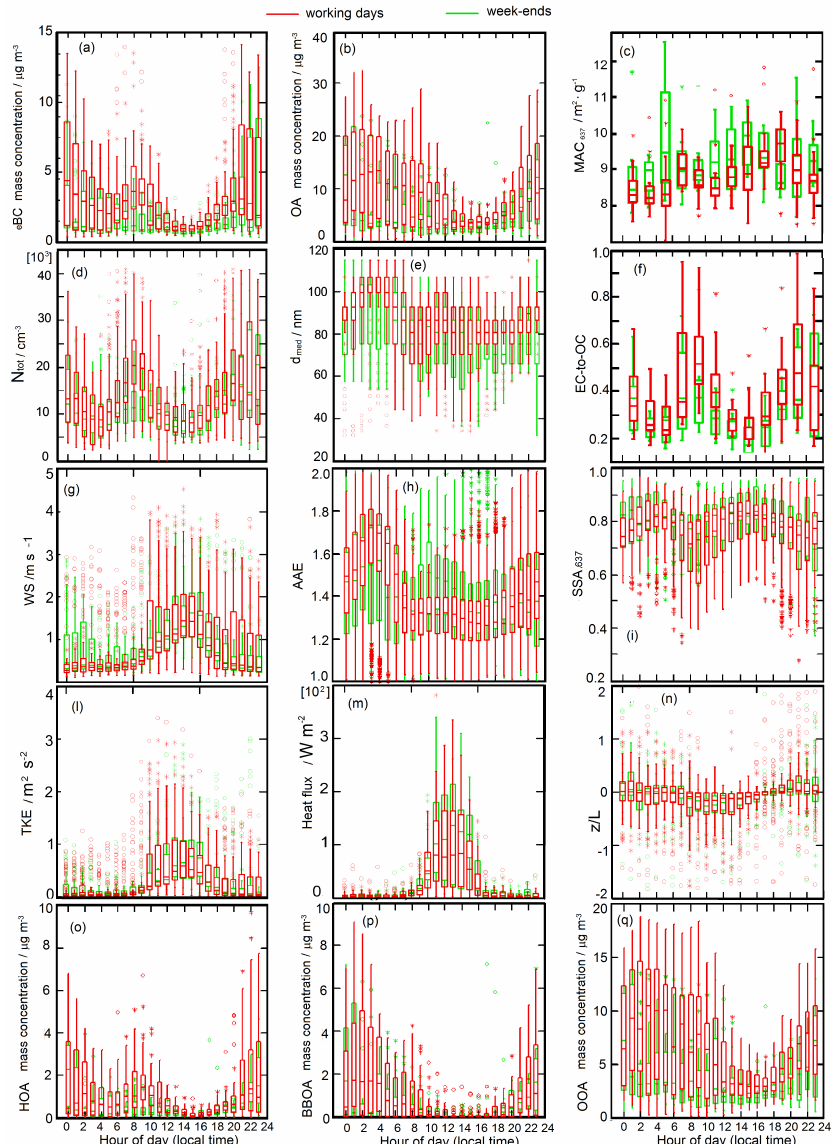
Figure 4. Diurnal and weekly cycles of: ( a ) eBC mass concentration; ( b ) OA mass concentration; ( c ) Mass Absorption Coefficient (MAC) at 637 nm; ( d ) total particle number concentration; ( e ) median diameter of the particle surface size distribution; ( f ) EC-to-OC ratios; ( g ) wind speed; ( h ) Absorption Ångström exponent (AAE) at 450–660 nm; ( i ) single scattering albedo (SSA) at 637 nm; ( l ) turbulent kinetic energy (TKE); ( m ) heat flux; ( n ) the inverse of the Monin Obukov length (z/L); ( o ) hydrocarbon-like OA mass concentration; ( p ) biomass burning OA mass concentration; and ( q ) oxidised OA mass concentration. The time resolution of data used to calculate the statistics (TR) is reported in Table 2 (if more than one TR, refer to the shortest one). Red and green bars show working days and weekend values, respectively. Data are presented as box-and-whisker plots. The boxes show median, first and third quartile, and the whiskers show the range of values that falls within the inner fences of the data (1.5 · the interquartile range). Circles show outliers (outside the outer fence) and asterisks show suspected outliers (between the inner and outer